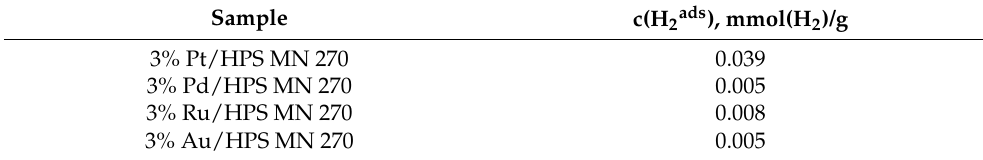
Table 3. Results of the studies of synthesized catalysts using H 2 chemisorption.